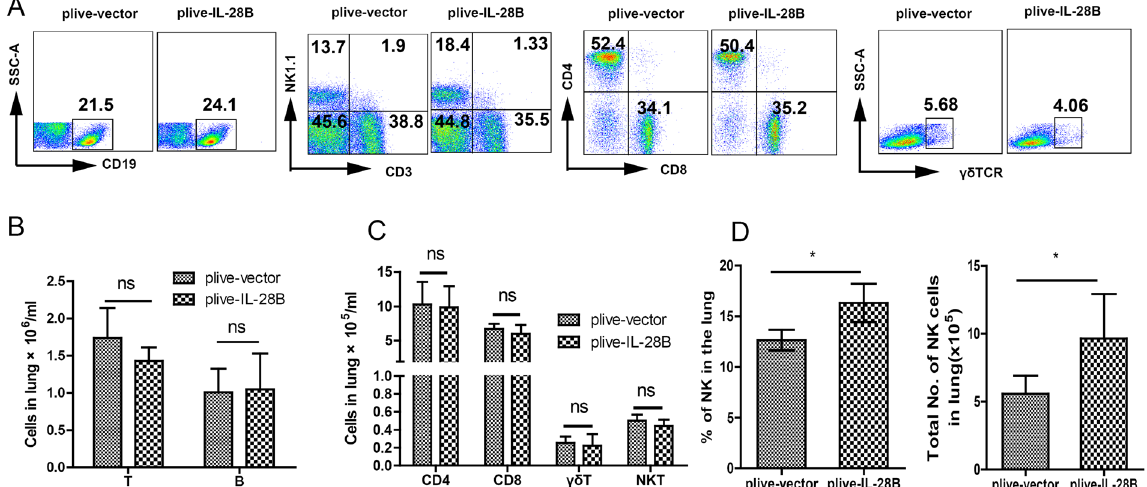
Figure 2. IL-28B increased the number and abundance of NK cells in lungs of asthmatic mice. ( A–C ) Flow cytometry ( A ) and cell counting assays ( B and C ) for frequency and numbers of lymphocyte subsets in the lungs of asthmatic mice. ns: non-significant. ( D ) Cell counting assay for frequency and number of NK cells in the lungs of asthmatic mice. * p < 0.05; ns: non-significant ( n = 5 mice per group). Results shown are representative of three independent